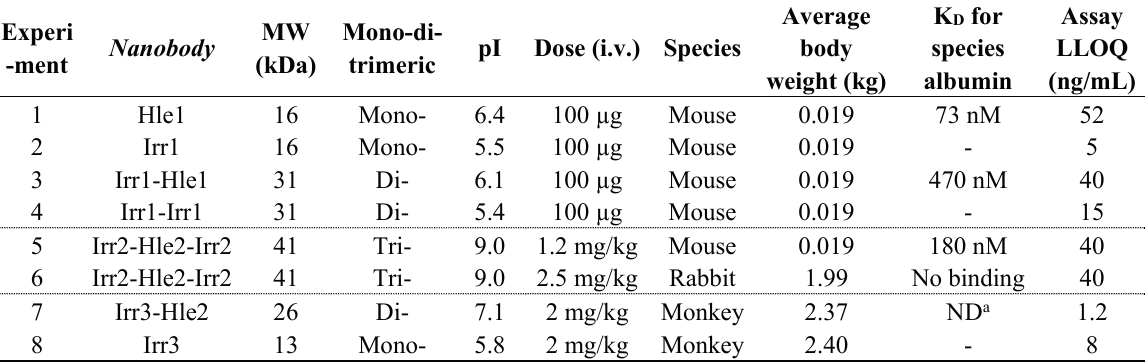
MW: Molecular Weight; Mono-di-trimeric: refers to the number of building blocks comprising one full Nanobody; pI: Isoelectric point; K D : Dissociation Constant; LLOQ: Lower Limit of Quantification of PK assay; Hle: half-life extended (anti-albumin) building block; Irr: irrelevant (no target binding) building block. a: ND, Not Determined: the K D based on human serum albumin was 31 nM and is expected to be similar to cynomolgus monkey serum